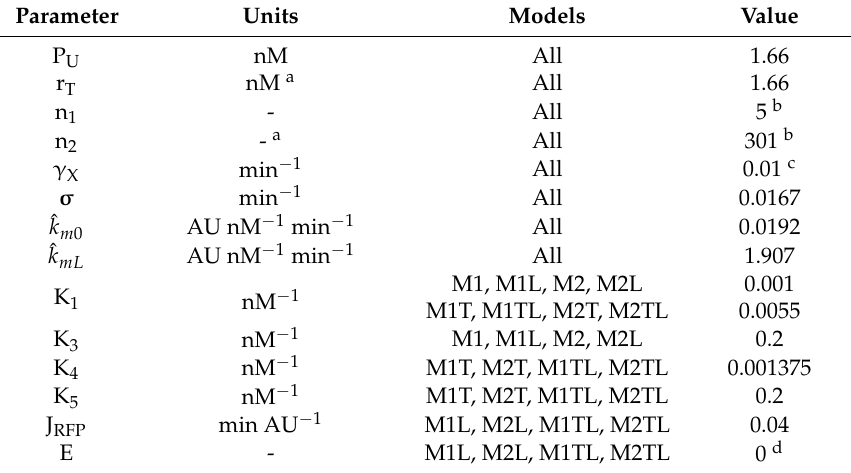
Table 1. Model parameters. The indicated values were used for simulation and, unless differently indicated, for the study of a posteriori